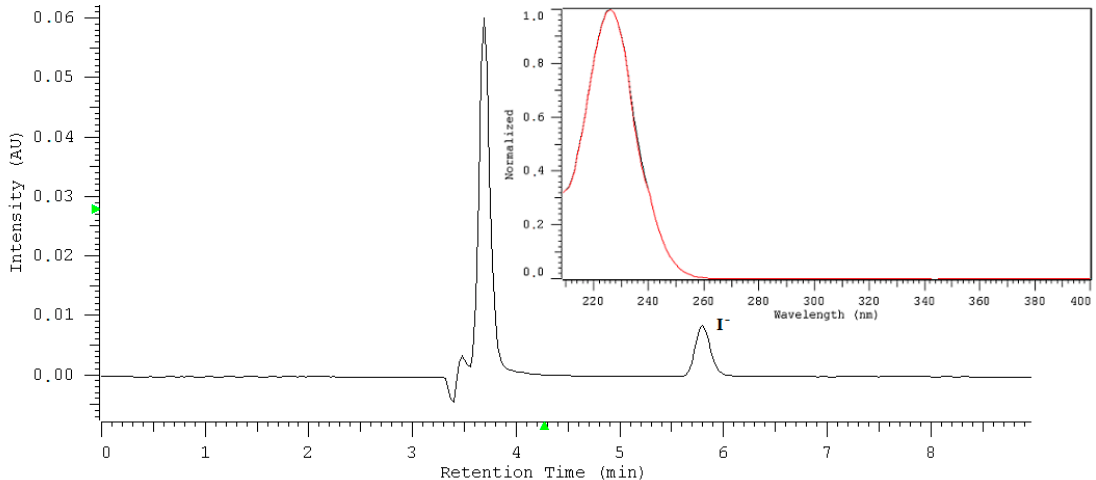
Figure 3. Chromatogram of sample W3. Insert: UV-absorption spectra of iodide in sample W3 recorded in the range of 190 to 400 nm. Conditions: stationary phase: IAM.PC.DD2 Regis HPLC (4.6 × 150 mm, 10 µm, pore size: 300 Å), mobile phase 30 mM NaCl/water, the flow rate 0.5 mL min − 1 , detection 226 nm.